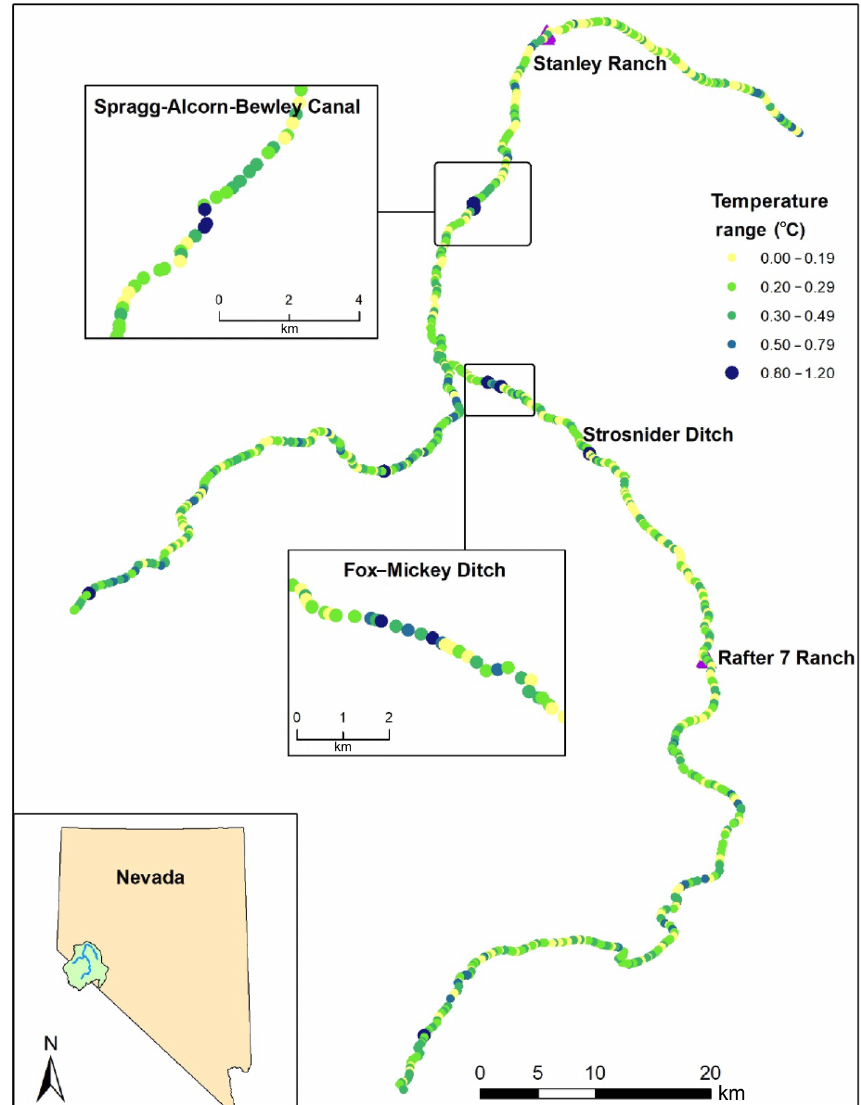
Figure 6. Temperature range within each 300m model reach from July 2012 TIR summary point data. Table 4. RMSE, MAE, mean bias, and percent of modeled dataset outside of measured values for the East, West, and main stem Walker rivers between hourly modeled, DTS, and TIR stream temperatures. RMSE MAE Mod.– Mod. > Mod. < n ( ◦ C) ( ◦ C) meas. meas. meas. (h)